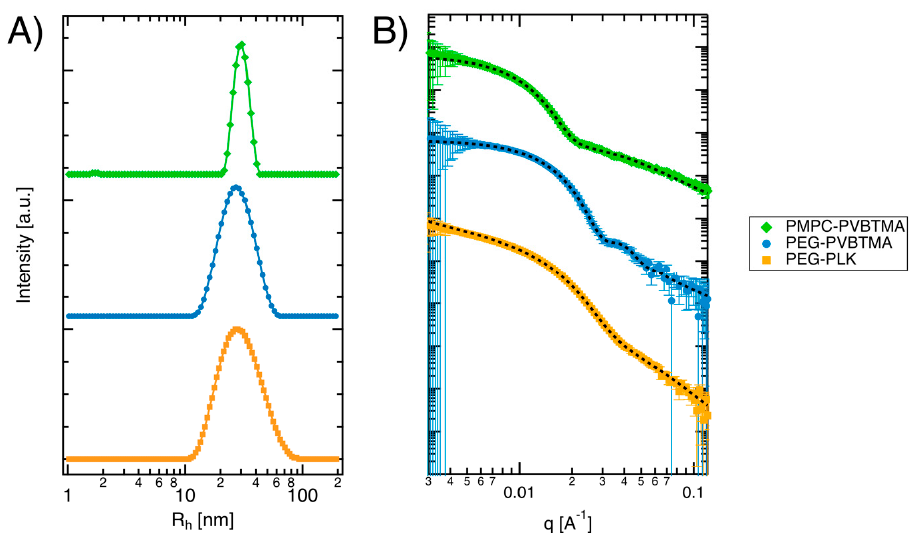
Figure 5. Comparison of ( A ) apparent size hydrodynamic radius ( R h ) distribution of neutral 10k -charged 100 micelles at 100 mM NaCl; DLS at 90° analyzed by regularized positive exponential sum (REPES) and ( B ) corresponding small angle X-ray scattering data (colored markers) and fits (black dashed lines). Intensity scaled for clarity; from bottom to top in both plots, the systems correspond to PEG 10K -PLK 93 /PAA 50 (orange squares), PEG 10K -PVBTMA 100 /PAA 50 (blue circles), and PMPC 10K -PVBTMA 97 /PAA 50 (green diamonds).